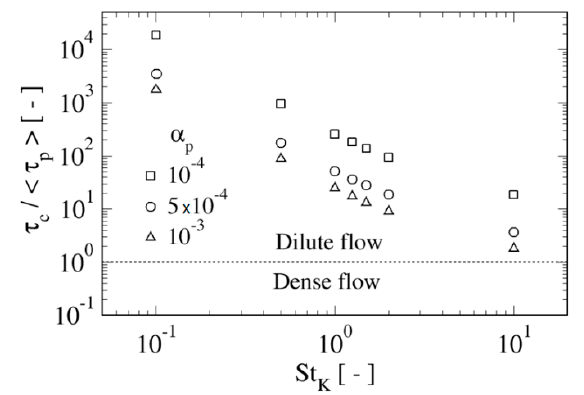
(cid:68) (cid:69) τ , as a function of particle Stokes number, St K , for the p